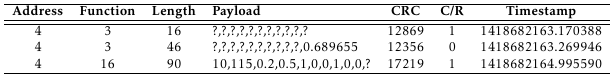
Table 3. Examples of the missing values in the gas pipeline data set.